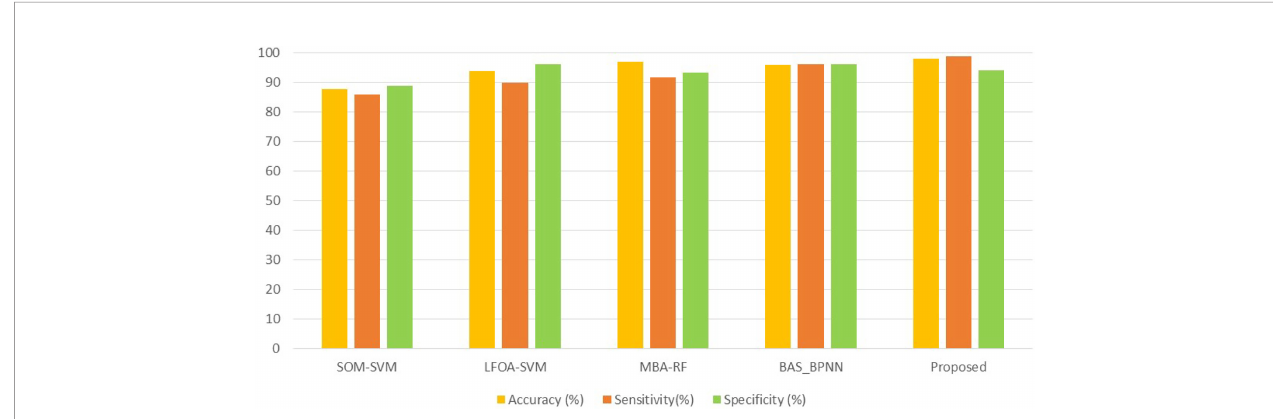
FIGURE 12 | Performance comparison with existing methods.